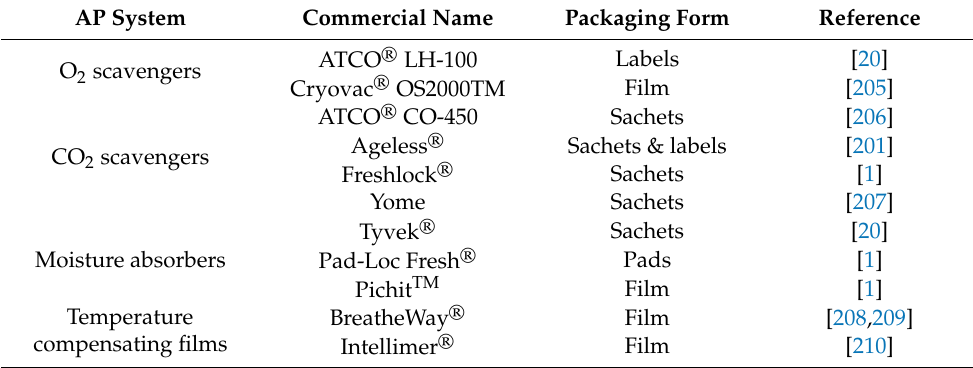
Table 9. Comparison between different intelligent systems.